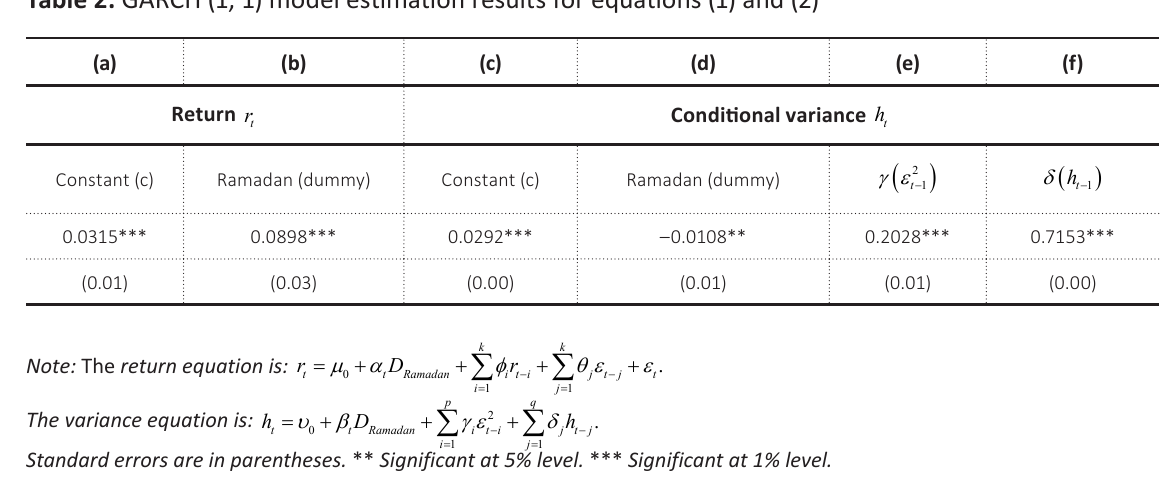
Table 2. GARCH (1, 1) model estimation results for equations (1) and